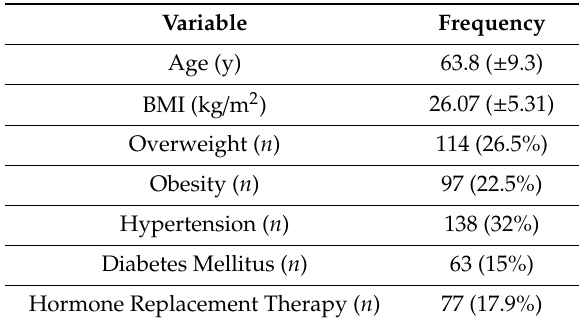
Table 2. General features of patients included in the